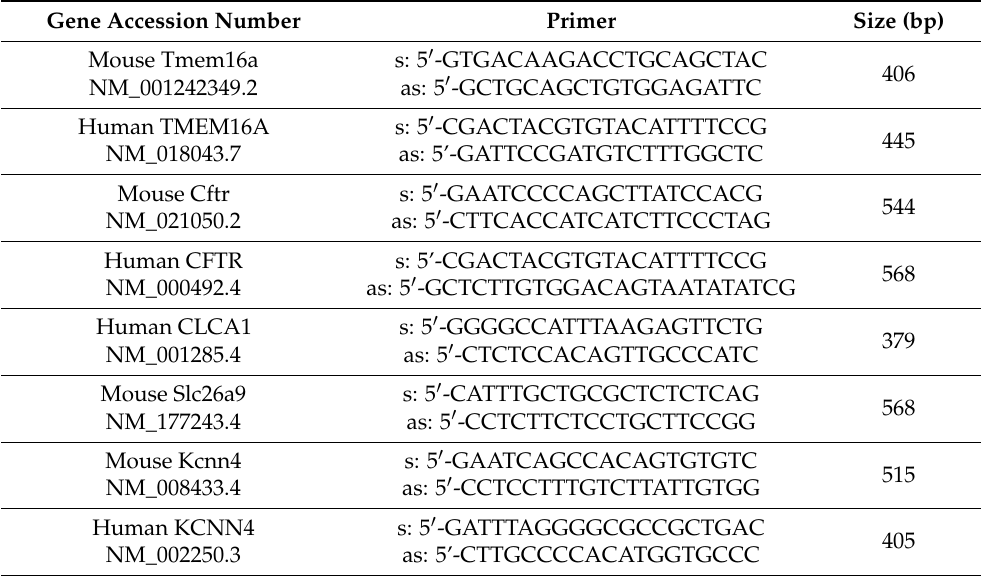
Table 1. Primers used for